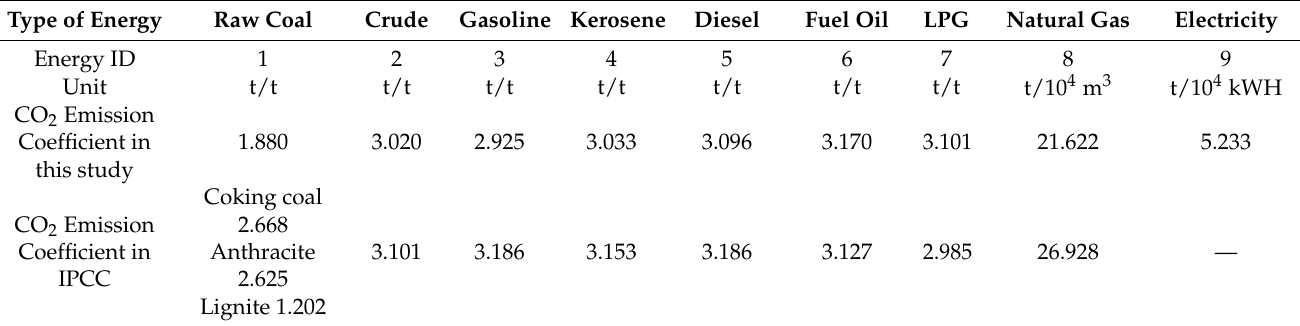
Table 2. Carbon dioxide emissions coefficient of various fossil fuels and